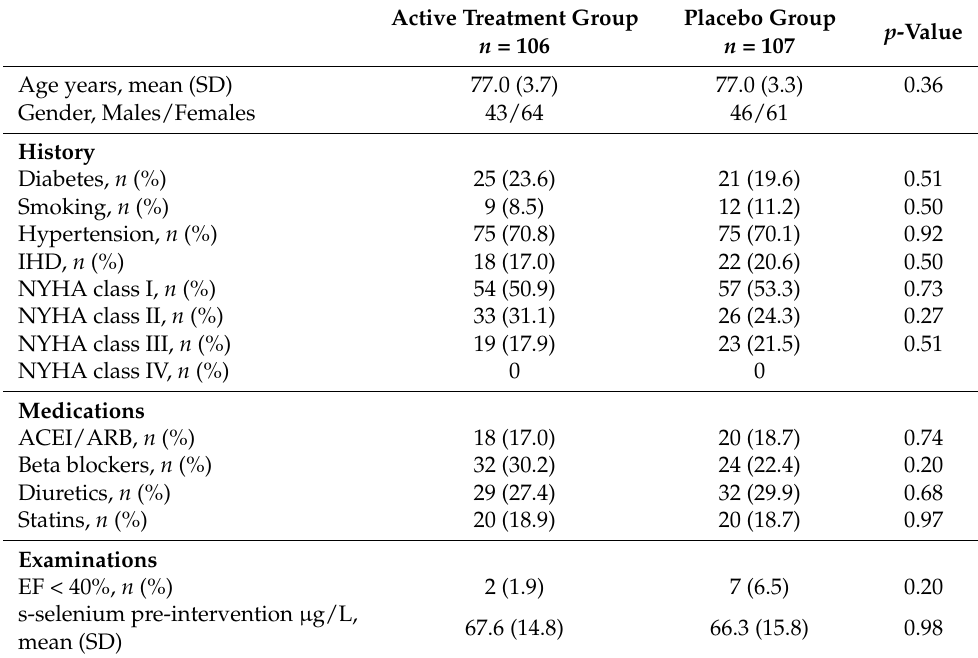
Table 1. Baseline characteristics of the study population receiving dietary supplementation of selenium and coenzyme Q 10 combined or placebo during four